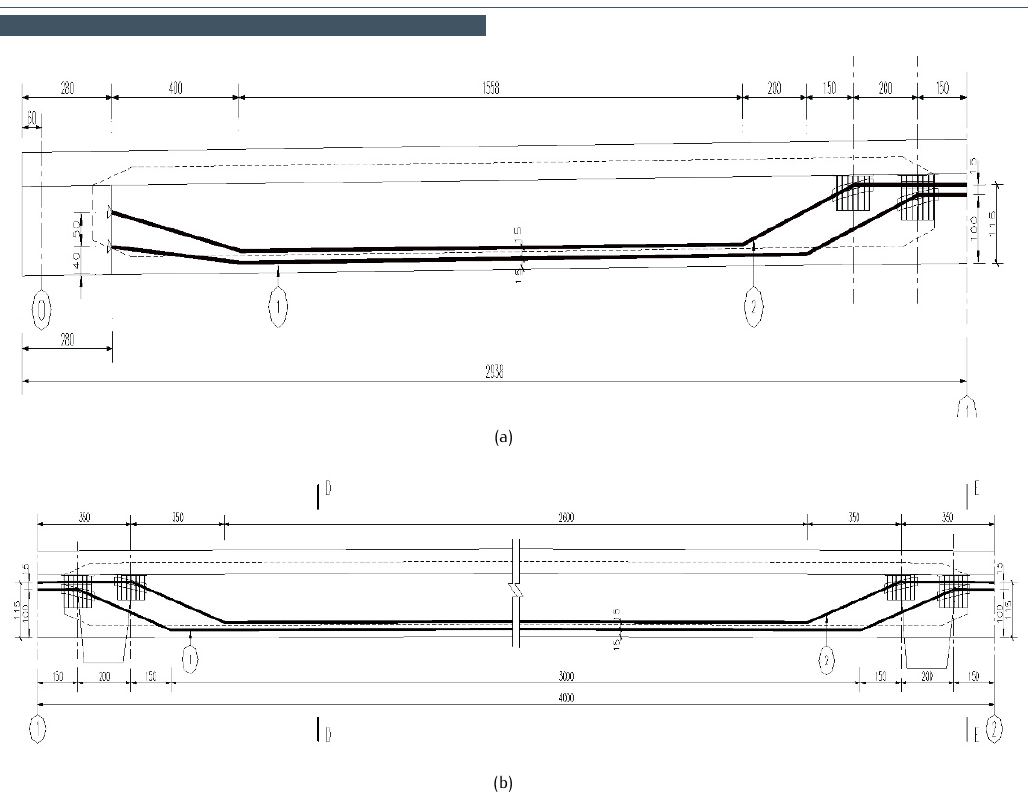
Figure 6. The longitudinal layout of prestressing tendons of thickening webs: (a) elevation view of span No.1, (b) elevation view of span No.2